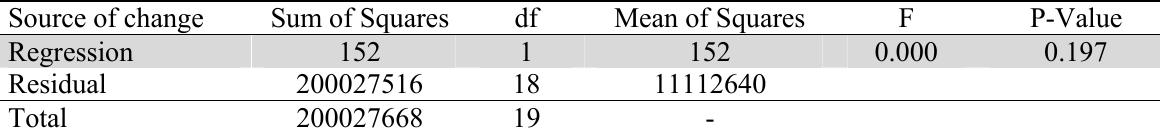
The results of ANOVA test